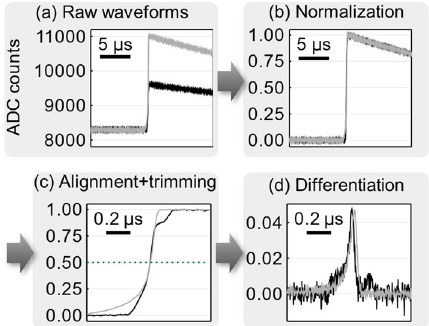
Fig. 3 PreprocessingstepsshownfortheMSeventfromFig.1b(black curve)andapresumedSSeventwith2578keVenergy(graycurve).The raw waveforms ( a ) are baseline-subtracted and normalized to a charge of one ( b ), aligned at the intersection with a threshold of 0.5, then trimmed to a 1 µ s long window ( c ), and finally differentiated yielding